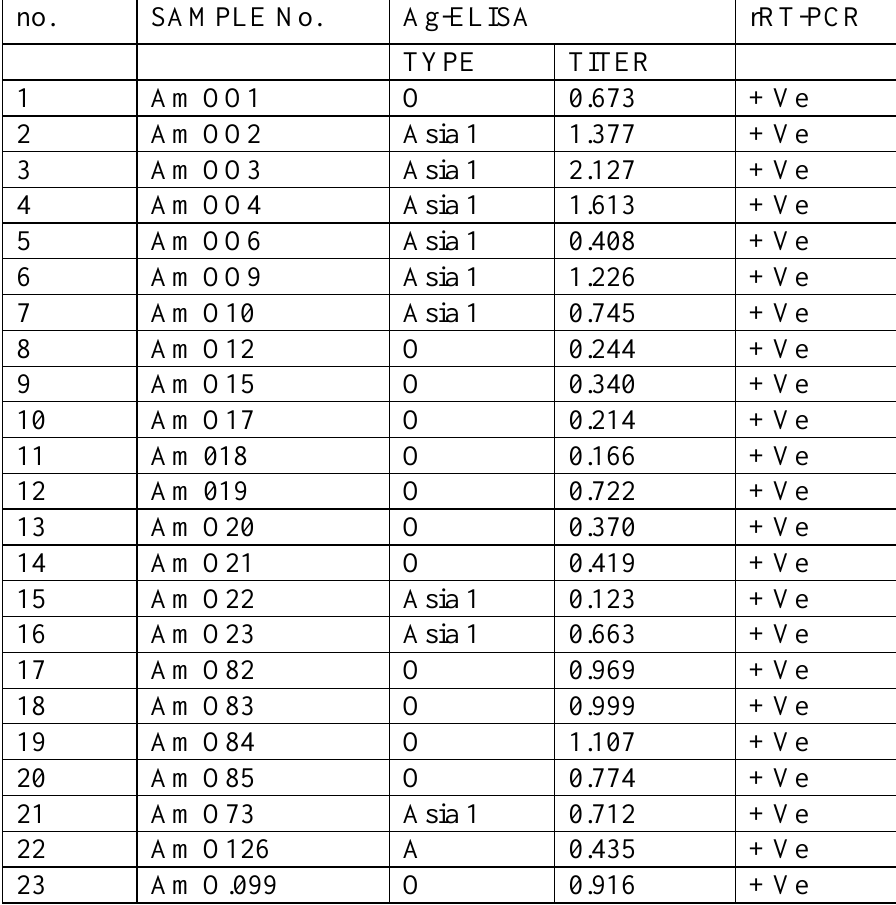
TABLE -2-: The results of detection of FMD vin biological material involve both Ag- ELISA and